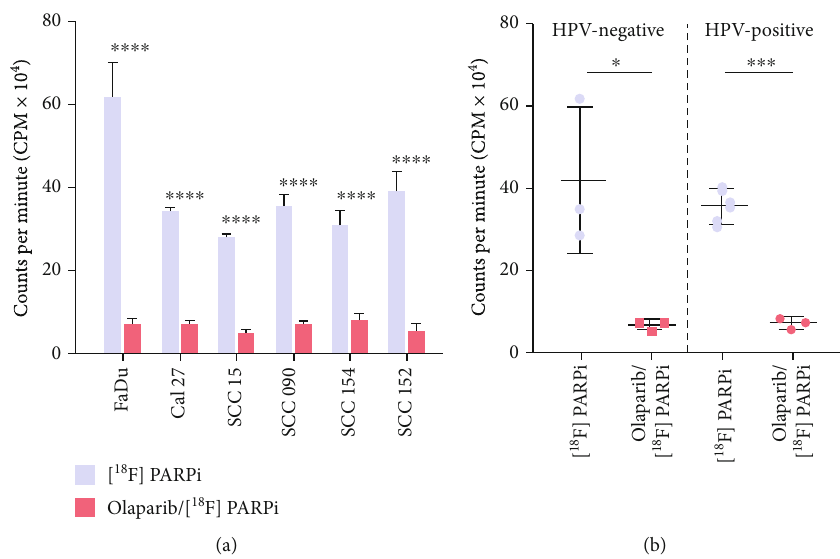
Figure 6: [ 18 F]PARPi uptake in HPV-negative and HPV-positive cell lines. (a) In vitro internalization assay of 370 kBq of [ 18 F]PARPi showing signi fi cant speci fi c tracer uptake. Uptake was blocked using 100-fold excess Olaparib 1 h before adding [ 18 F]PARPi. (b) Quanti fi cation of total uptake in relation to HPV status showing no signi fi cant di ff erence of HPV-negative and HPV-positive cell lines ( ∗ P < 0 : 05 , ∗∗∗ P < 0 : 001 , ∗∗∗∗ P < 0 : 0001 , Student t